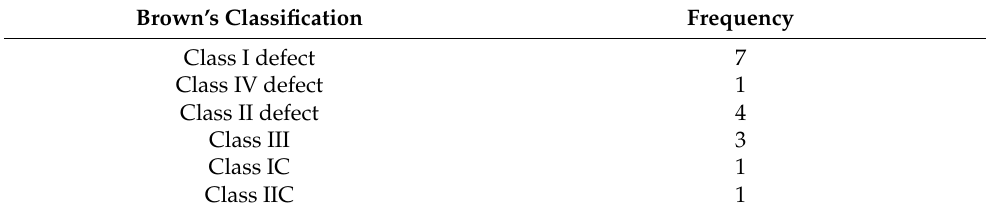
Table 4. Distribution of defect extent.